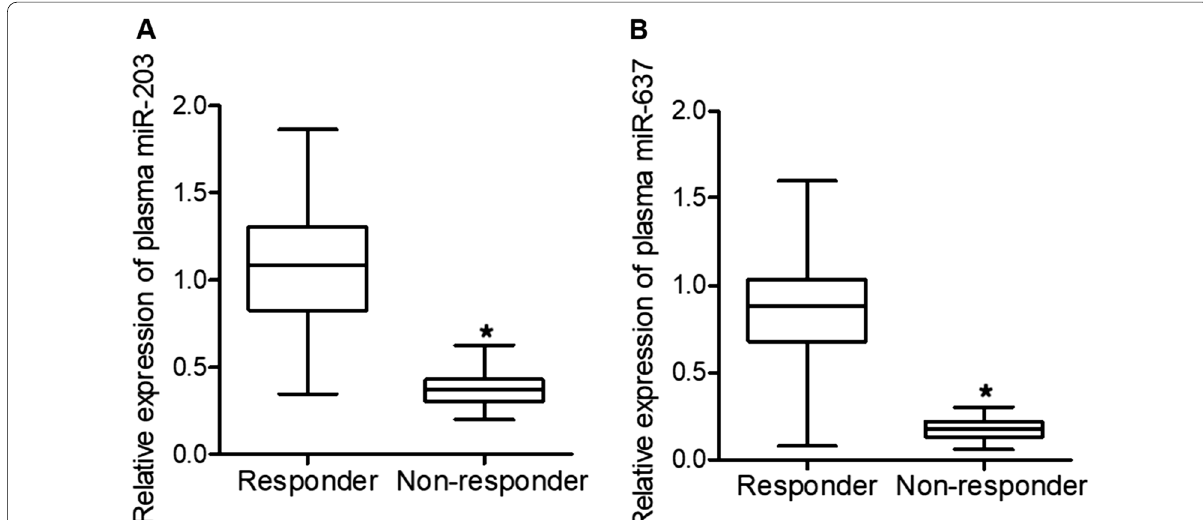
Fig. 4 Expression of miR‑203 and miR‑637 were lower in non‑responder patient groups (*P value < 0.05 vs. responder group). A The expression of miR‑203 was down‑regulated in CML patients sensitive to IM; B The expression of miR‑637 was down‑regulated in CML patients sensitive to IM